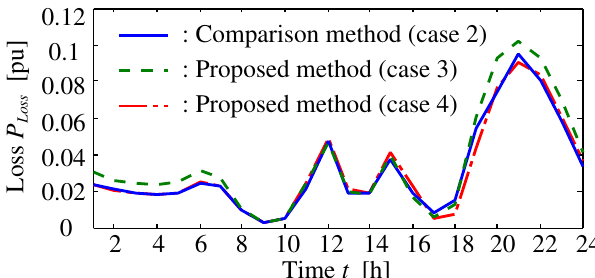
Figure 12. Comparison of distribution losses for each